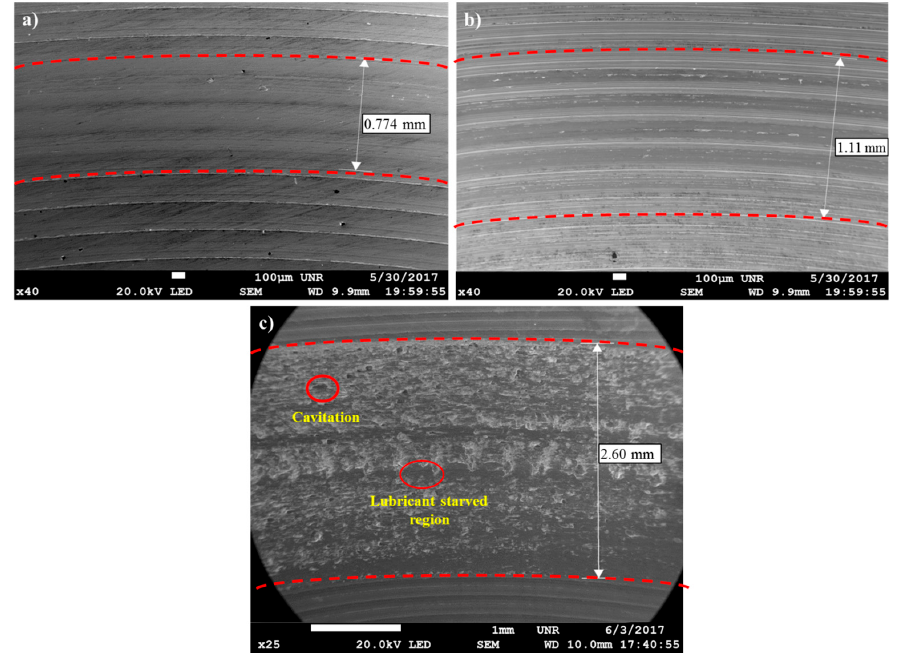
Figure 9. Wear track under scanning electron microscope (SEM) post tribo-corrosion testing.